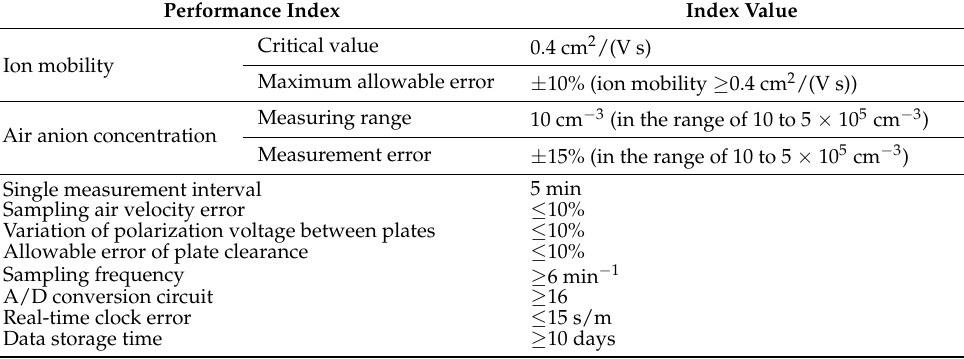
Table 2. Accuracy of each